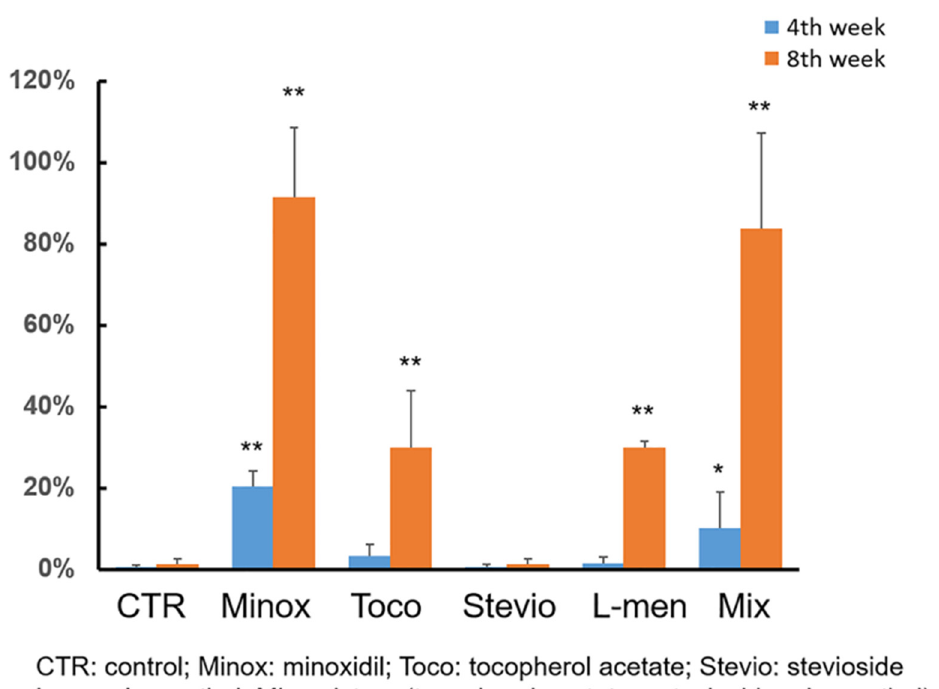
Figure 3. Quantitative comparison of hair growth. The hair growth area was scanned and measured with Image J. The value is represented as the percentage of the hair growth area relative to the shaved area. The average value is shown, with error bar indicating standard deviation. The calculations excluded the highest and lowest values in each group. Statistical analyses were performed in comparison with the vehicle-treated control group (* p < 0.05; ** p < 0.01; n = 3).